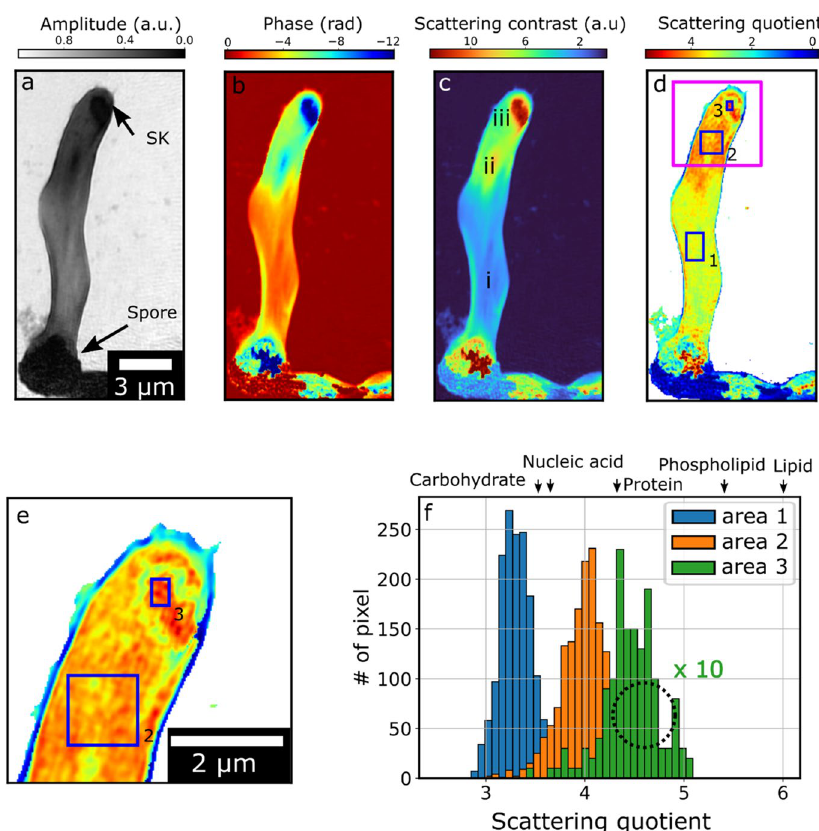
Fig. 3 High-resolution EUV image of A. nidulans . a and b show the reconstructed amplitude and unwrapped phase respectively. At the bottom, the spore is visible, which shows low transmission. While at the center the tubulus is visible and at the top, the high phase shift at the top indicates the Spitzenköper (SK). In c the scattering contrast is shown, where three regions are indicated by i, ii, and iii. d shows the scattering quotient. e shows the magnified region indicated in d by the pink box. f Histogram of the scattering quotient in the blue boxes in d and e by the blue boxes labeled 1, 2, 3. The number of pixels for area 3 is multiplied by a factor of 10 to facilitate